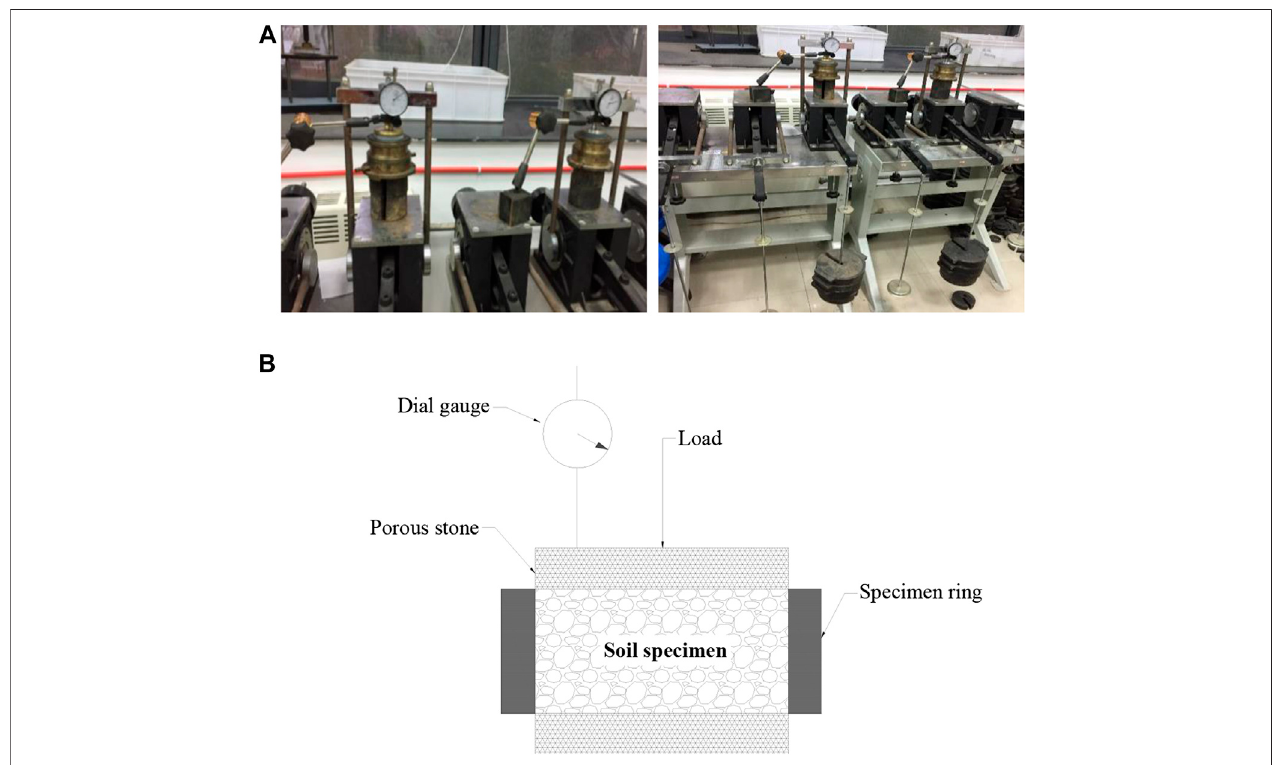
FIGURE 2 | Loading device. (A) Laboratory loading device and consolidation test in progress; (B) schematic diagram of a